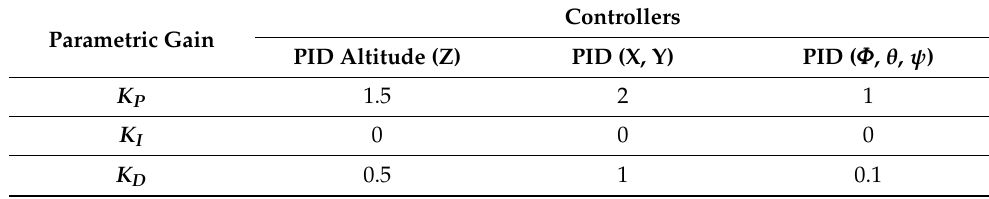
Table 3. Parametric Gain values of each PID